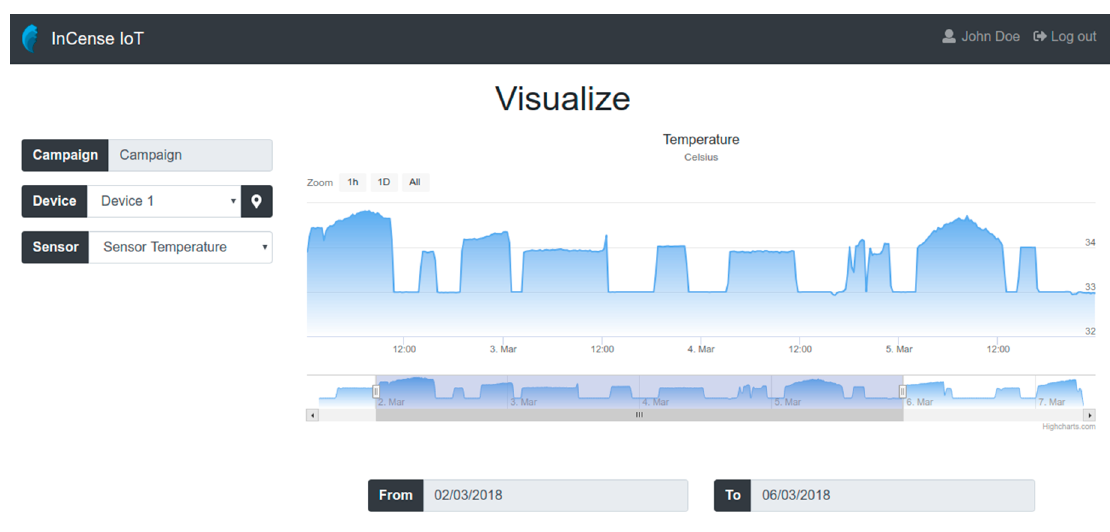
Figure 2. GUI of the Sensing Campaigns Manager.